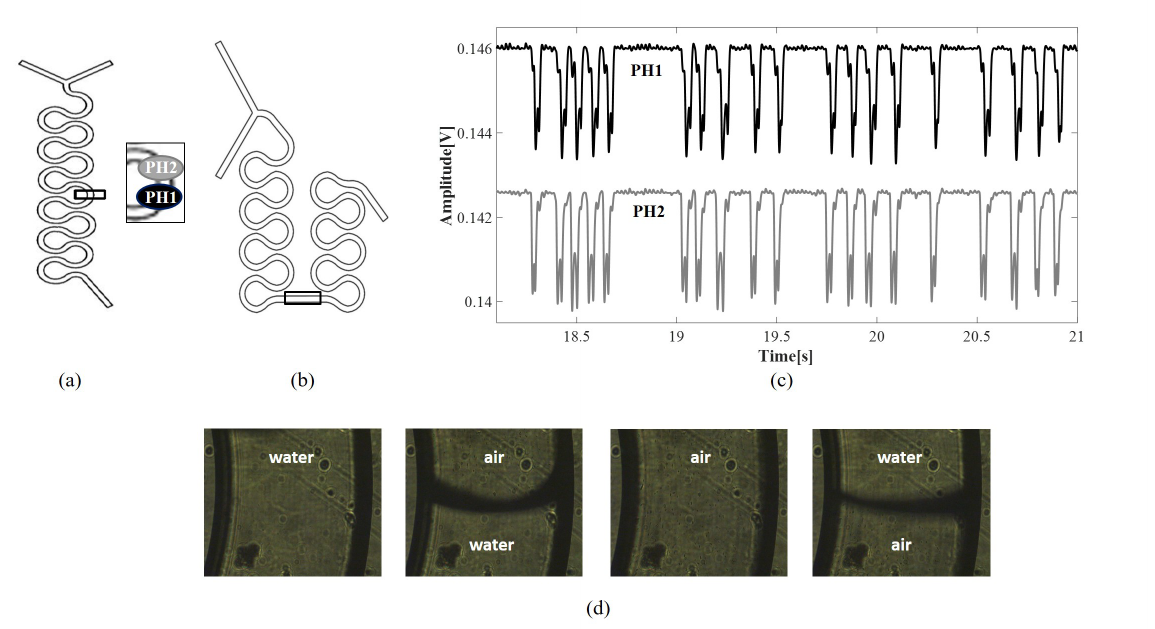
Figure 2. ( a ) the geometry of the serpentine channel of 320 µ m (labelled as G-320); ( b ) the geometry of serpentine channel of 640 µ m (labelled as G-640); ( c ) an example of the trends of the signals acquired by the two photo-diodes { ph1, ph2 } in G-320 in the experiment with an input flow rate F = 0.3 mL/min. The two rectangles in G-320 and G-640 point out the investigation areas where the two-photo-diodes are placed; ( d ) a frame sequence related to the slug passage acquired by the